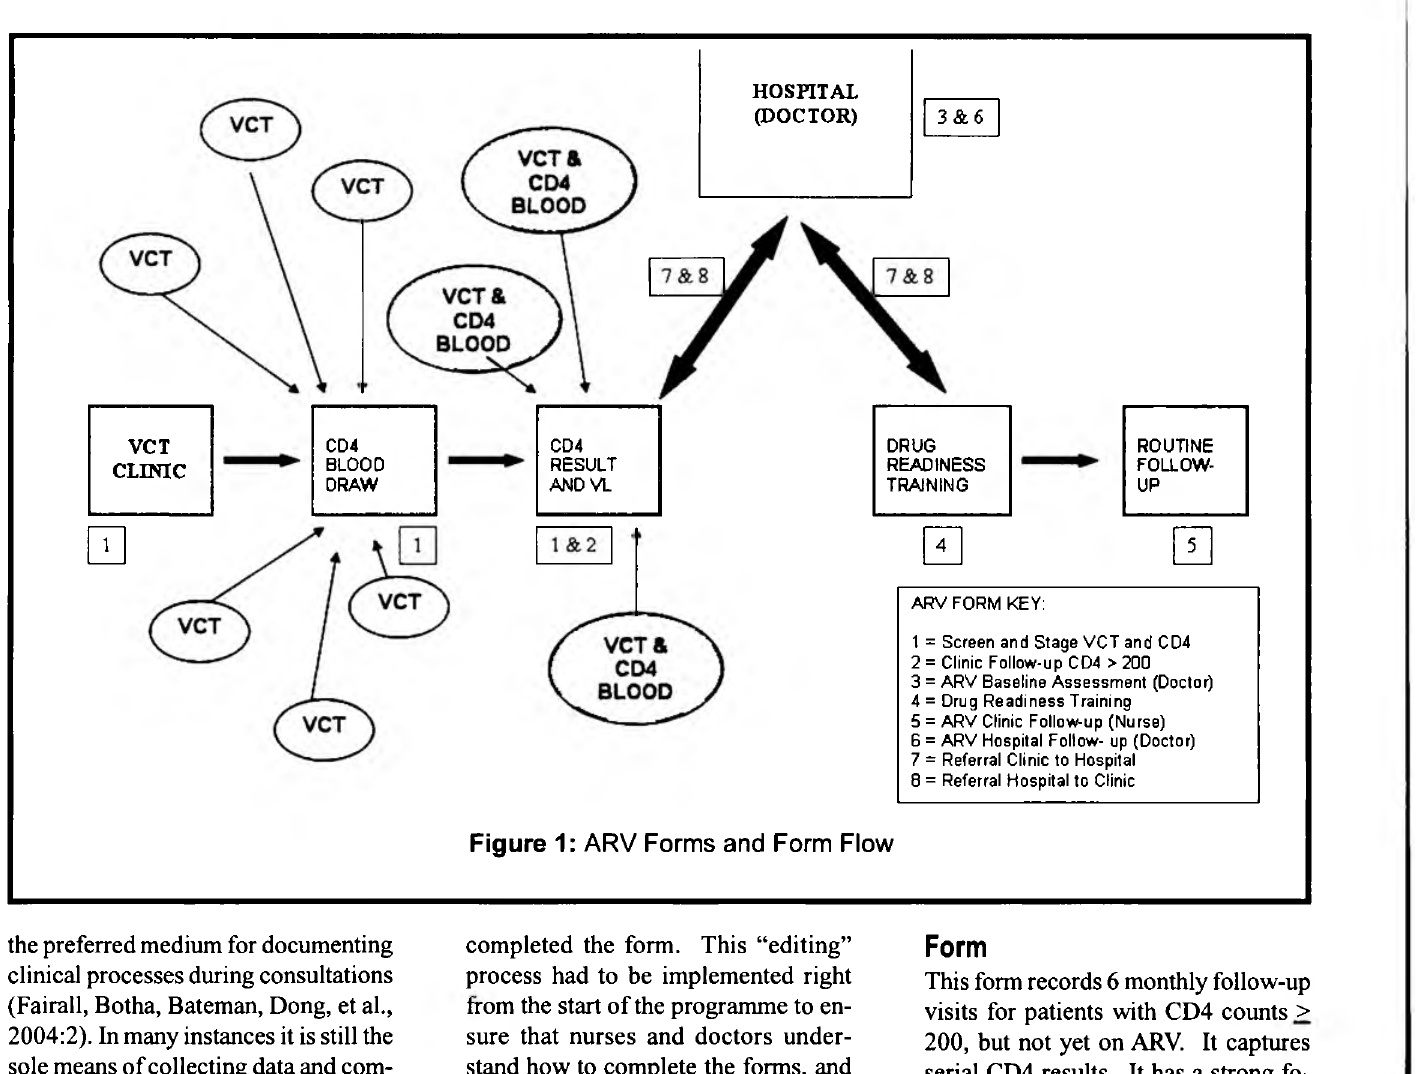
Figure 1: ARV Forms and Form Flow